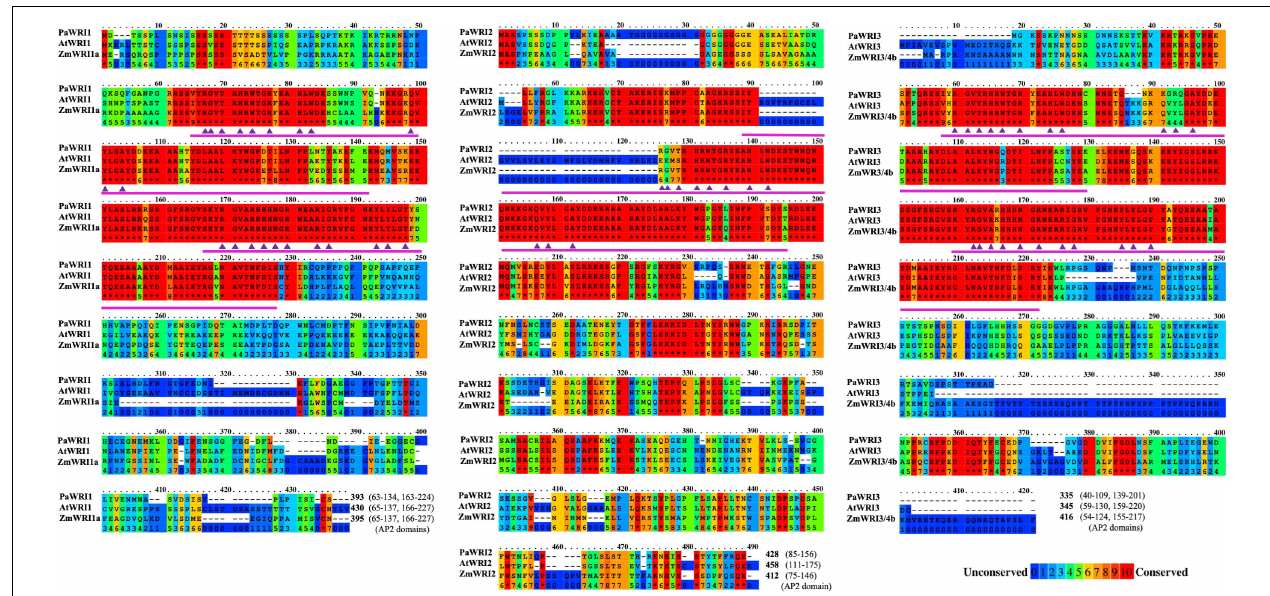
FIGURE 1 | Primary sequence features of WRI homologs. Multiple sequence alignment of primary sequences of WRI1, 2, and 3 from P. americana (Pa), A. thaliana (At), and Z. mays (Zm) in a color-coded format; red and blue colors represent the most (10, indicated by asterisk) and least (0) conserved regions, respectively, on a scale of 0 to 10. Position of the AP2 domains and sequence length are indicated at the end of the alignment. The amino acid residues in the AP2 domain important for DNA interaction are represented by ( (cid:78)